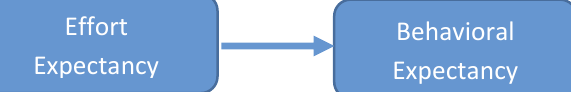
Fig. 2 Relations effort expectancy and behavioral intention Source (Tahrini,